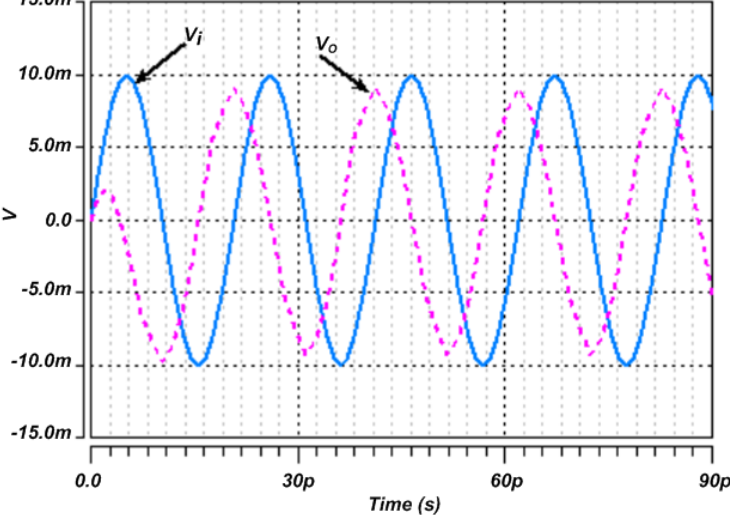
Figure 10. Transient-response of AOTAPF at pole- f o = 49.26 GHz and V tune = − 0.32